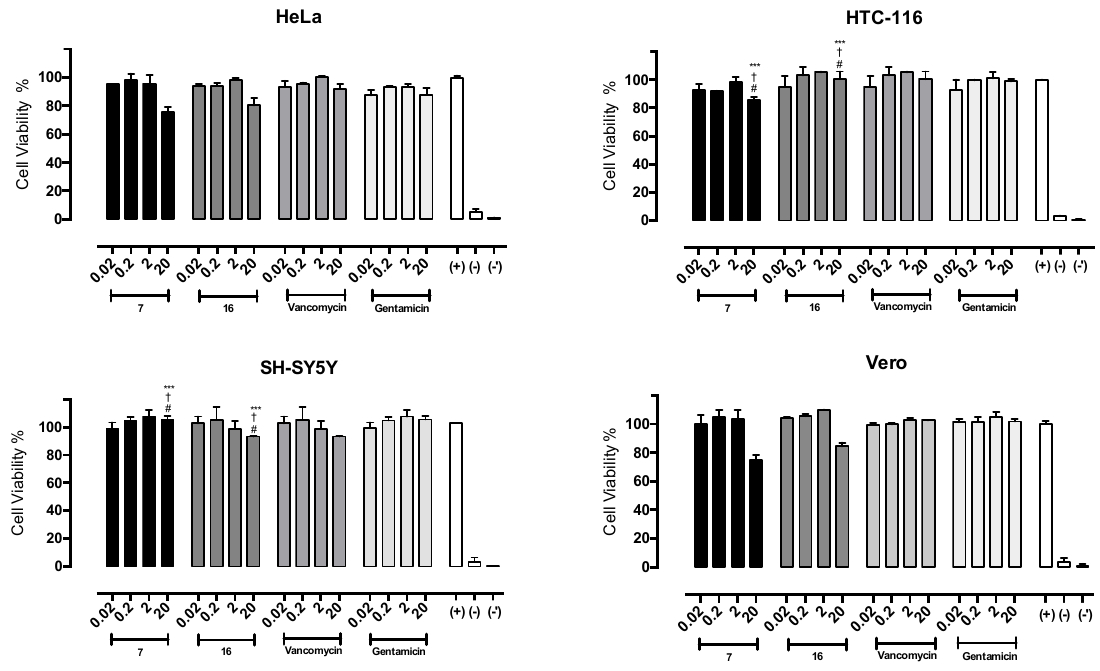
Figure 4. In vitro toxicity of compounds 7 and 16 ( n = 3) over HeLa, HTC ‐ 116, SH ‐ SY5Y and Vero cell lines, in the range of 0.02 to 20 μ g/mL in triplicated. (+) Positive growth control, RPMI 140 medium. ( − ) Negative growth control. ( −′ ) Negative growth additional control, 1% DMSO + H 2 O. Vancomycin and Gentamicin were used as drug reference. ***: p < 0.001 = statistically no significant differences with positive growth control; #: p < 0.001 = statistically no significant differences with vancomycin; †: p < 0.001 = statistically no significant differences with vancomycin.